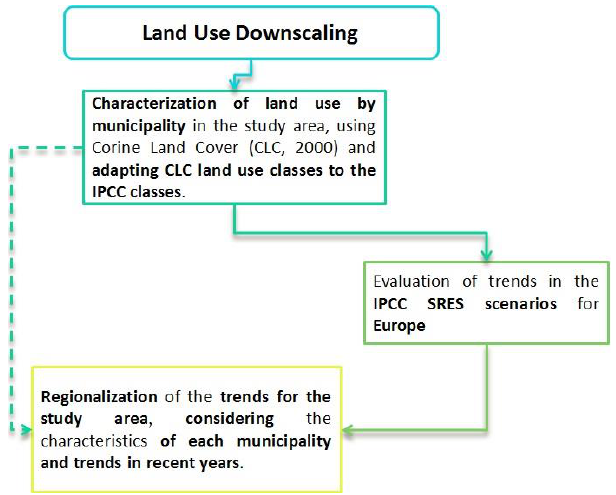
Figure 4 - Land Use Downscaling Methodology. Source: Adaptaclima-EPAL project report (2011). Figure 4. Land Use Downscaling Methodology. Source: Adaptaclima-EPAL project report